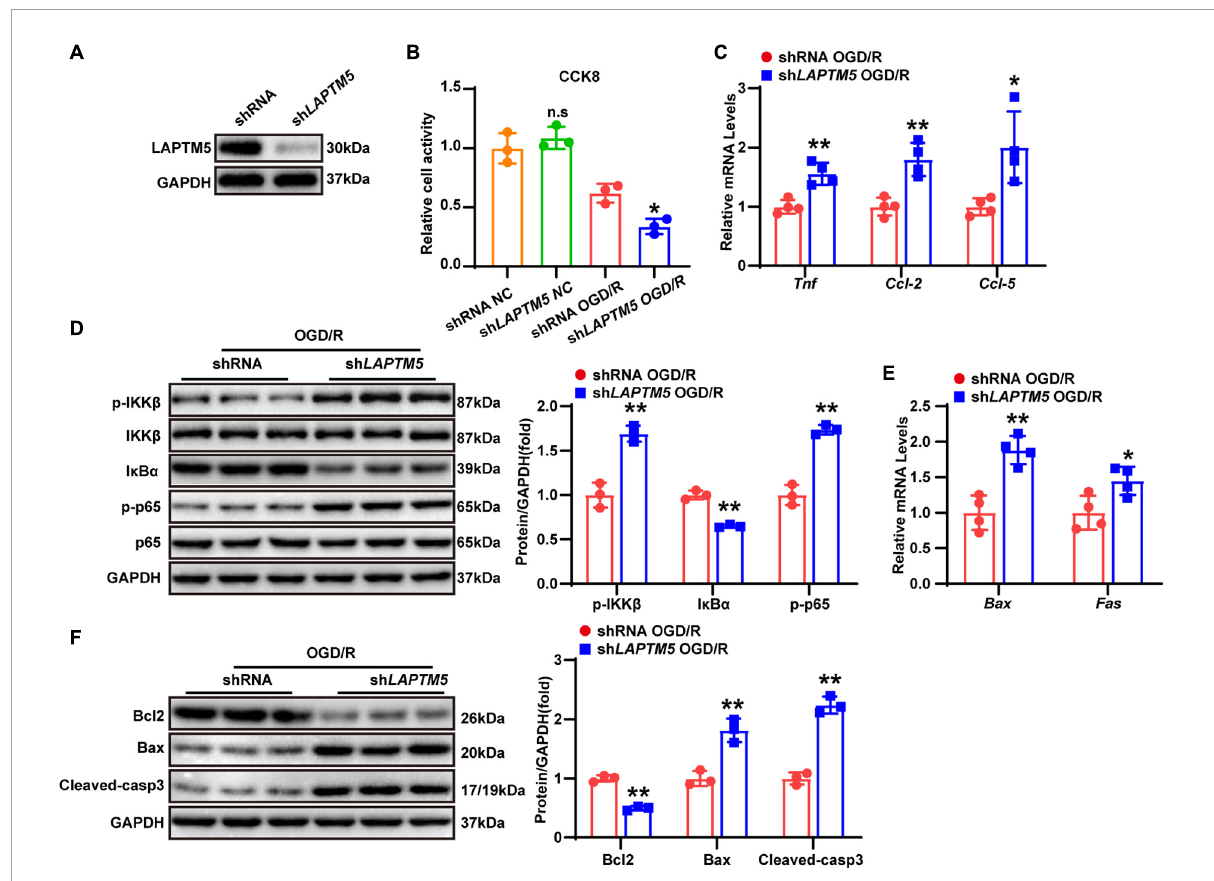
FIGURE5 LAPTM5 knockdown aggravates neuronal inflammation and apoptosis in primary neurons treated with OGD/R. (A) Western blot of LAPTM5 expression in the control and LAPTM5 knockdown primary neurons. (B) CCK8 assays revealed lower cell viability in the LAPTM5 knockdown group after OGD/R treatment, while LAPTM5 knockdown did not affect viability of neurons cultured under normal conditions, n = 3 independent experiments, * p < 0.05 vs. the shRNA OGD/R group. n.s. indicates no significance vs. the shRNA NC group. (C) LAPTM5 knockdown upregulated the mRNA levels of proinflammatory genes ( Tnf, Ccl-2, and Ccl-5 ) after OGD/R, n = 4 independent experiments, * p < 0.05, ** p < 0.01 vs. the shRNA OGD/R group. (D) Western blot analysis showed that the protein levels of phosphorylated IKK β and p65 were increased, while that of I κ B α was decreased in the sh LAPTM5 group after OGD/R, n = 3 independent experiments, ** p < 0.01 vs. the shRNA OGD/R group. (E) RT-qPCR showed increased pro-apoptotic gene ( Bax, Fas ) expression in the sh LAPTM5 group after OGD/R, n = 4 independent experiments, * p < 0.05, ** p < 0.01 vs. the shRNA OGD/R group. (F) Western blot showed decreased expression of anti-apoptotic proteins (Bcl2), while pro-apoptotic proteins (Bax and Cleaved-caspase 3) were increased in the sh LAPTM5 group after OGD/R, n = 3 independent experiments, ** p < 0.01 vs. the shRNA OGD/R